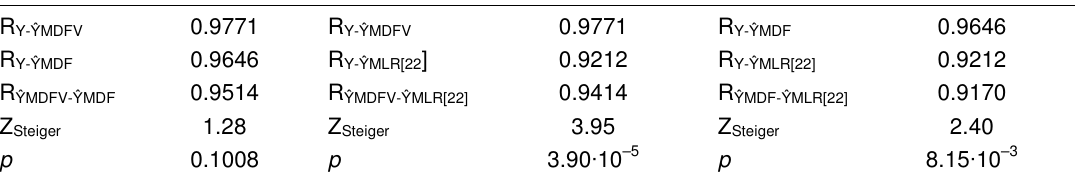
Results of Comparisons: Steiger’s Test (Degree of Freedom = 34) Parameter MDFV vs. MDF